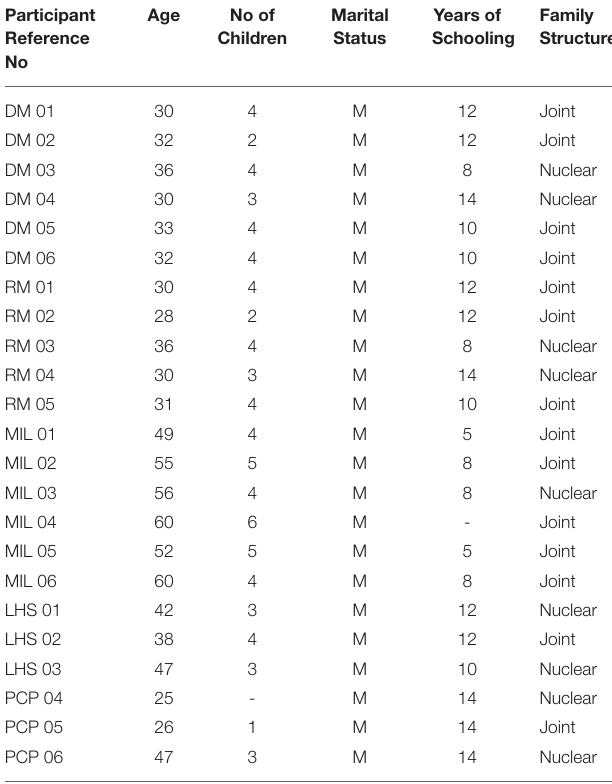
TABLE 1 | Socio-demographic characteristics of the